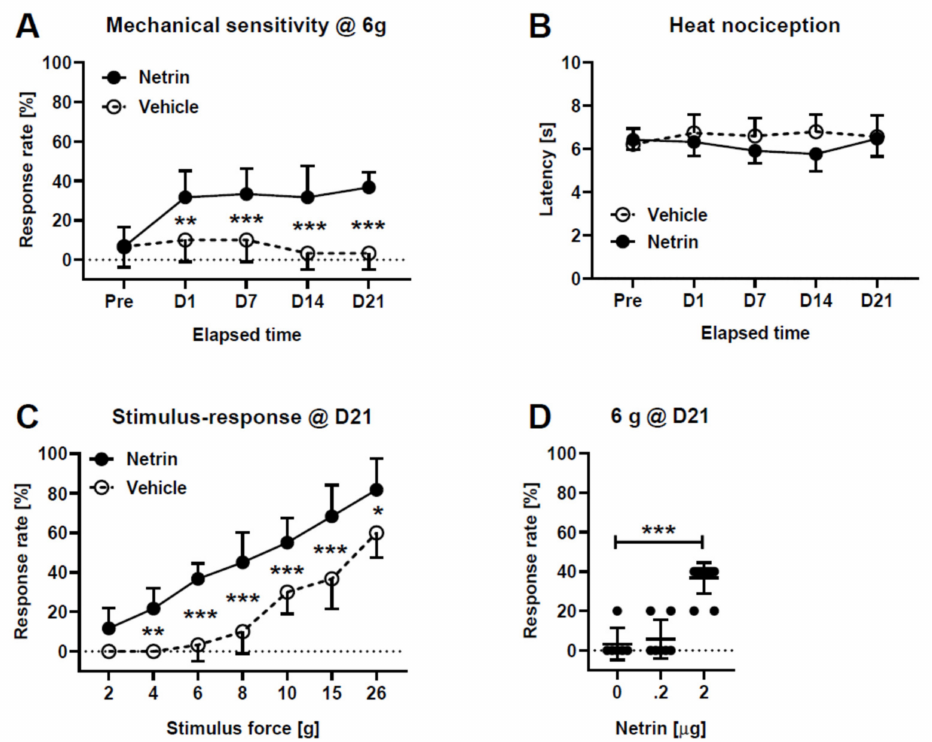
Figure 1. Mechanical sensitivity ( A , C , D ) and heat nociception ( B ) after intrathecal administration of netrin-1. ( A ) shows limb withdrawal response tested at the force of 6 g at various time points. ( B ) shows paw flick latency to heat at various time points. ( C ) shows limb withdrawal response to various test stimulus forces 21 days after treatment. ( D ) shows the effect of drug dose on the behavioral effect 21 days after treatment. The dose of netrin-1 in ( A – C ) was 2.0 µ g. D1–D21 in- dicate days after treatment. The graphs show mean values and the error bars represent S.D. (n Net2.0 = 12, n Net0.2 = 7, n Veh = 6). In the Y -axis, increase in the response rate to